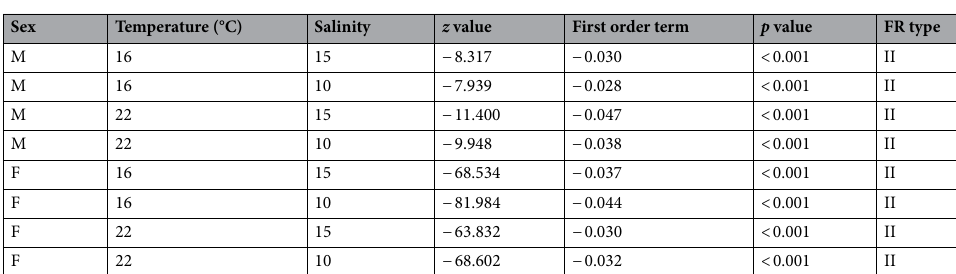
Table 2. First order terms and significance levels from logistic regressions, with functional response (FR) type, z values, first order terms and p values for all experimental treatment groups with Hemigrapsus takanoi feeding on Mytilus edulis prey. M and F denote male and female,